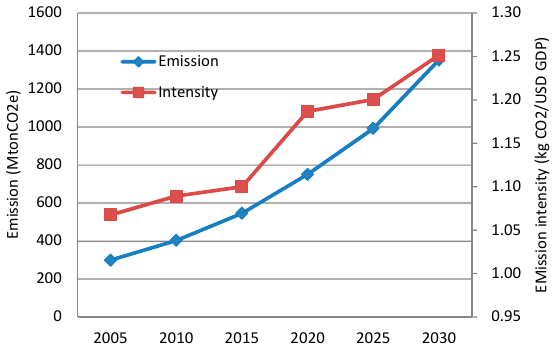
Figure 6. GHG emissions and emission intensity, baseline scenario. USD; US dollars. GDP; Gross domestic Production.